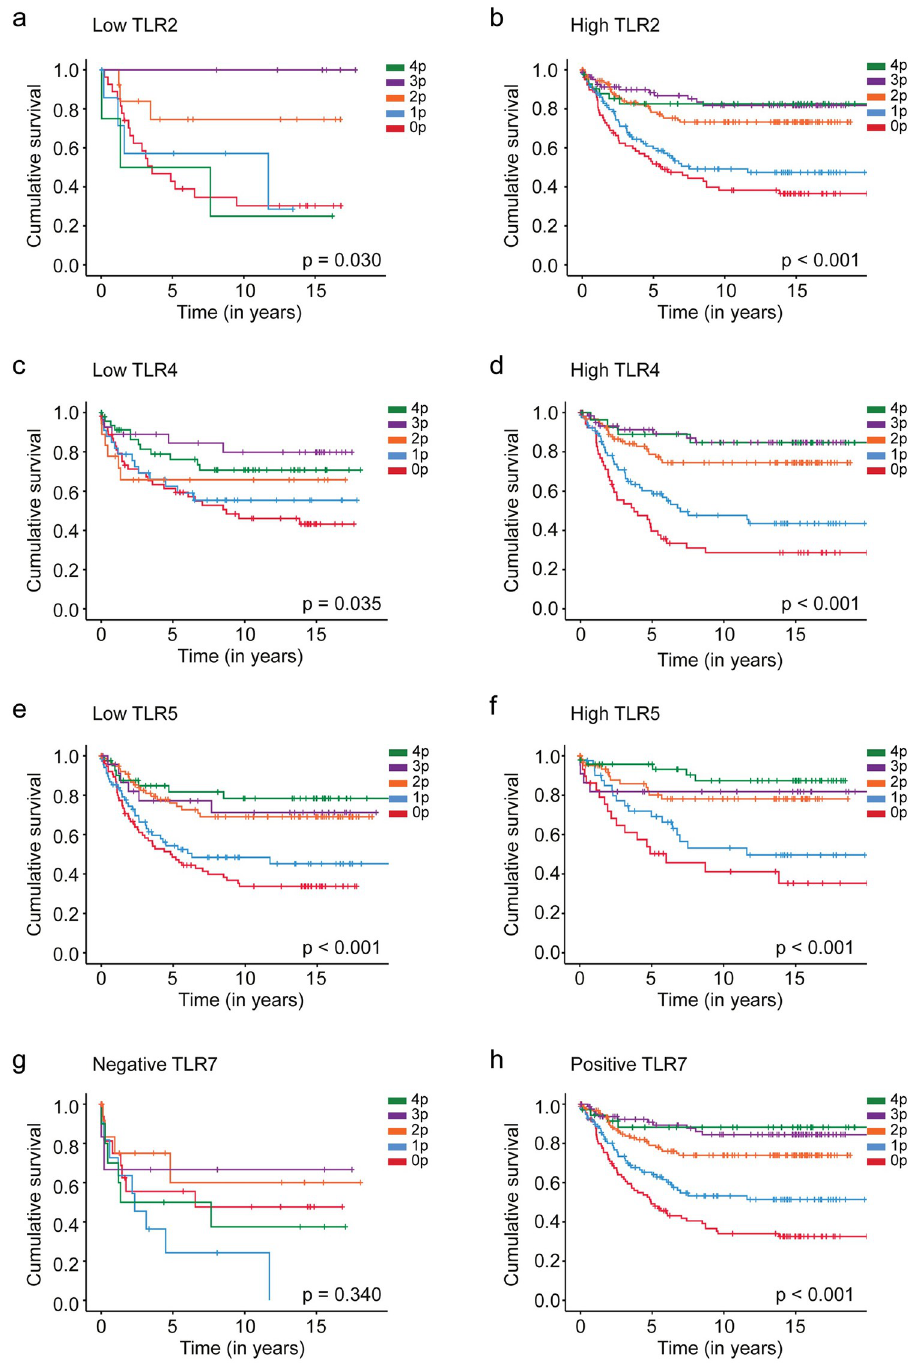
Fig 3. Disease-specific survival analysis of colorectal cancer patients using the Kaplan–Meier method. CD3–CD8 five-point index among ( a ) low TLR2 expression patients, ( b ) high TLR2 expression patients, ( c ) low TLR4 expression patients, ( d ) high TLR4 expression patients, ( e ) low TLR5 expression patients, ( f ) high TLR5 expression patients, ( g ) TLR7-negative patients, and ( h ) TLR7-positive patients. The log-rank test was used.